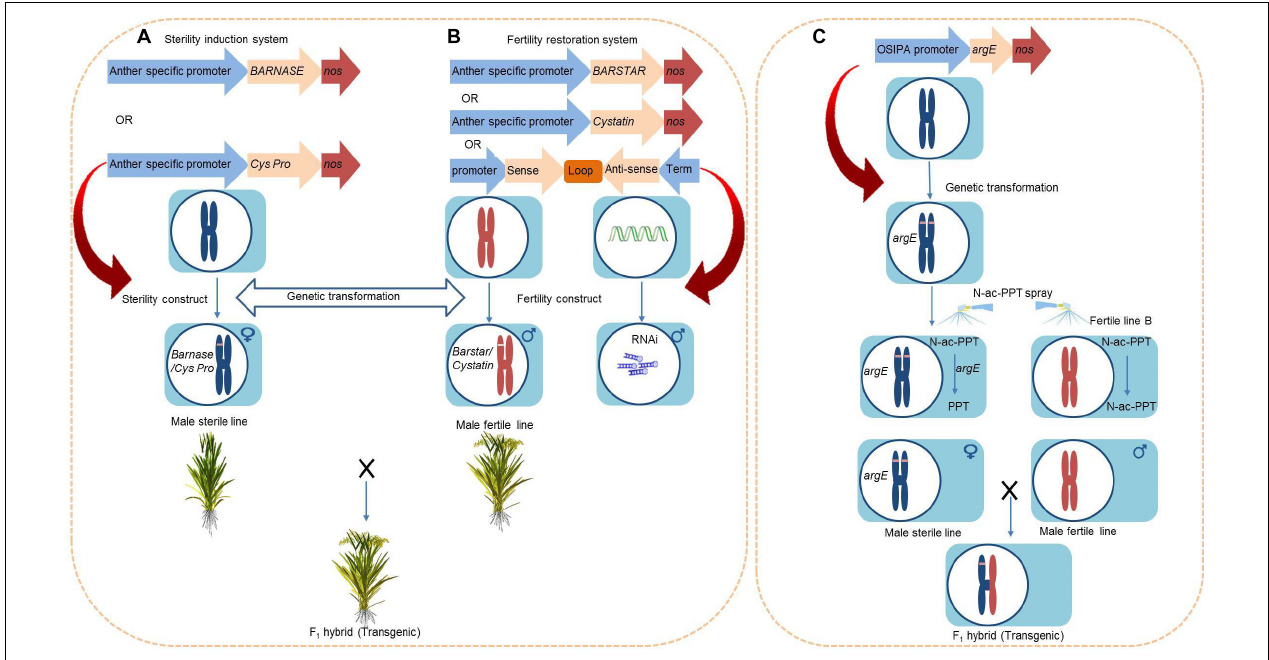
FIGURE 6 | Work flow for the construction of transgenic male sterility. (A) Barbase/Barstar or Cysteine Protease/Cystatin . (B) Fertility restoration system. (C) Chemically induced male sterility system using argE